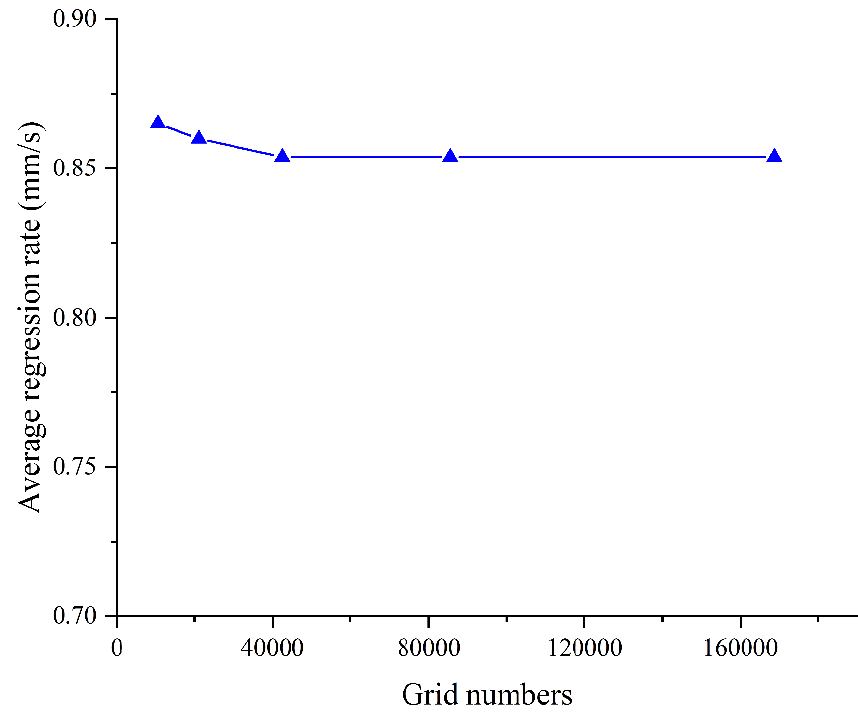
Figure 3. Average regression rate at different grid numbers.